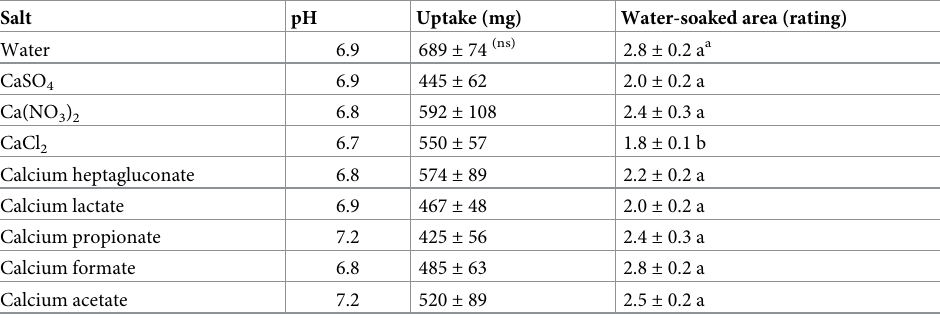
(ns) Means do not differ significantly from the control. a Mean followed by the same letter do not differ significantly from the control, Dunnett’s test at p = 0.05. Water soaking was indexed using a five-score rating scale: score 0, no water soaking; score 1, < 10% of the surface area water-soaked; score 2, 10 to 35%; score 3, 35 to 60%; score 4 >